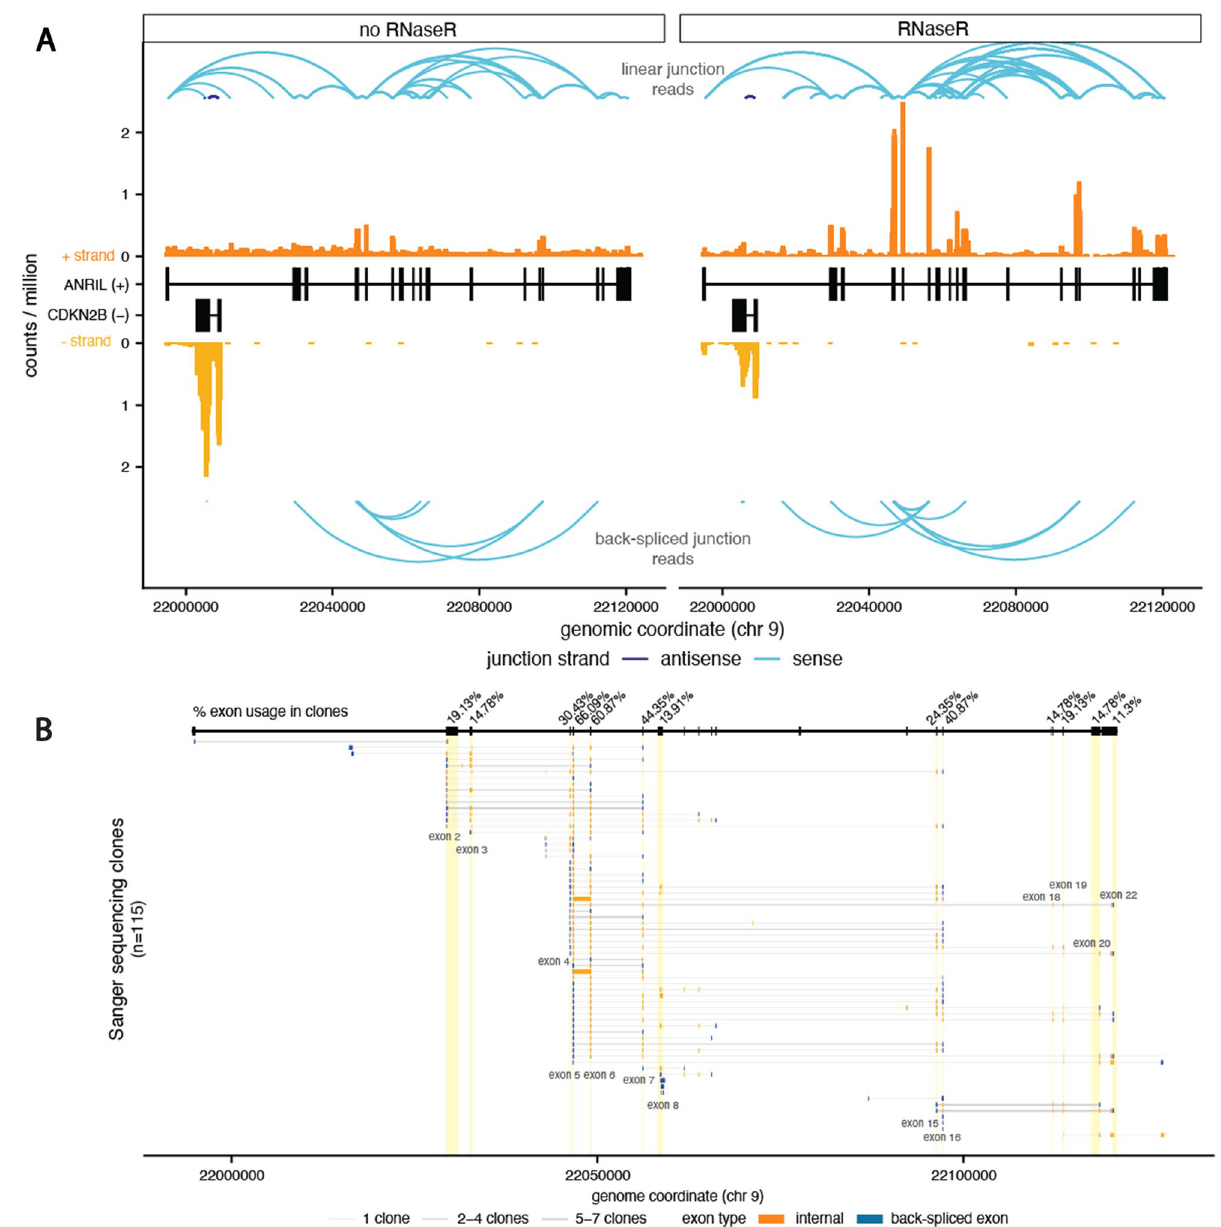
Figure 1. Transcription of ANRIL locus results in diverse circular RNAs. ( A ) RNA-seq data from the CDKN2B/ CDKN2B-AS locus from control ( left ) and RNaseR treated ( right ) RNA. Exonic read coverage is in orange shades and splice junction reads are in blue, differentiated by linear ( top , from STAR alignment) and back-spliced ( bottom , from CIRCexplorer2 alignment) junction reads. All read counts are normalized by the total number of reads in the libraries ( B ) Visualization of individual fragments identified by Sanger sequencing, with each row representing one isoform and the thickness of the lines representing the number of corresponding sequencing clones. Exons involved in back-splicing are represented in